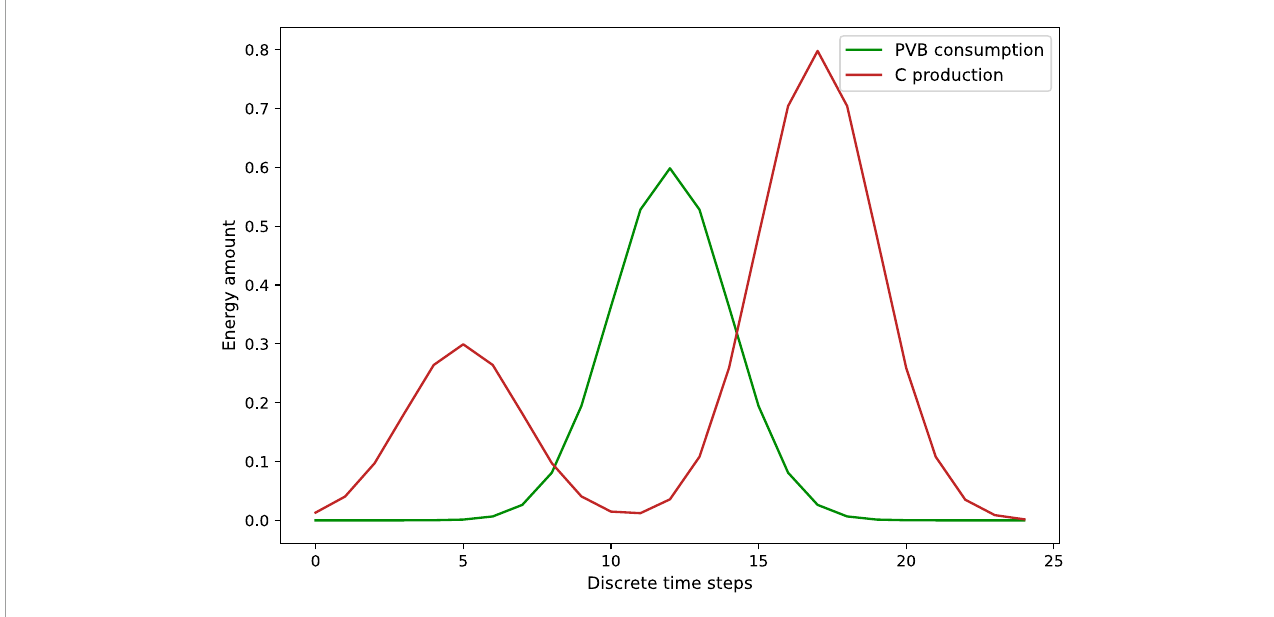
FIGURE 3 Consumption profile of the member C and production profile of the member PVB for the REC of Case 0.